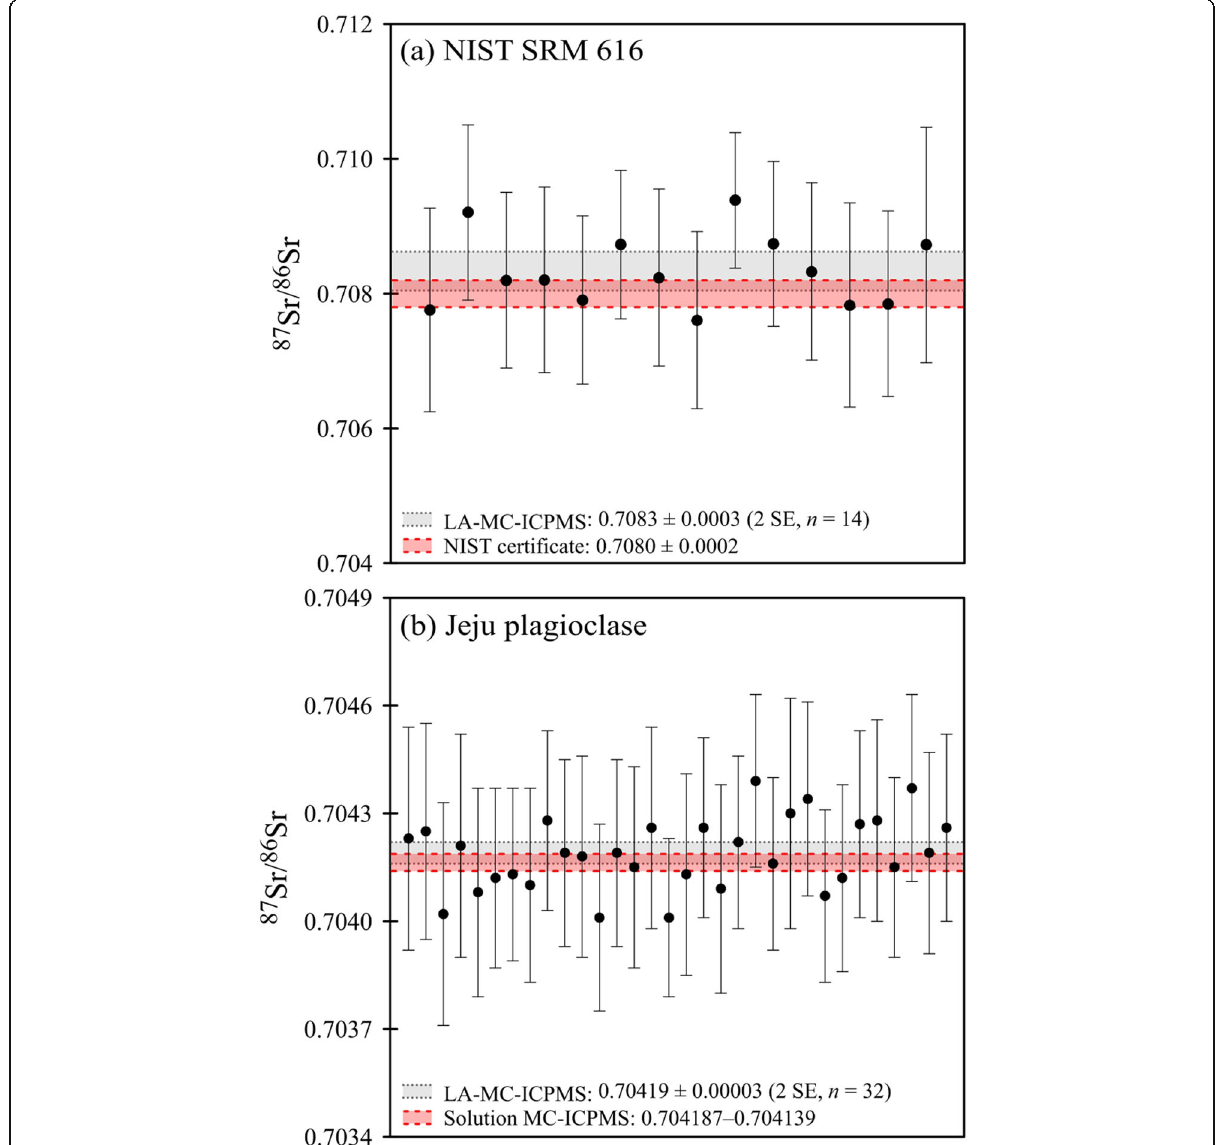
Fig. 1 87 Sr/ 86 Sr ratios obtained via LA-MC-ICPMS for NIST SRM 616 ( a ) and Jeju plagioclase ( b ) assuming equal mass bias factors for Rb and Sr. Vertical error bars denote 2 standard errors. Gray dotted lines represent average LA-MC-ICPMS results. Red dashed lines represent the certified value ( a , 0.7080 ± 0.0002; Wise and Watters 2012) and the solution MC-ICPMS result ( b , 0.704187 –